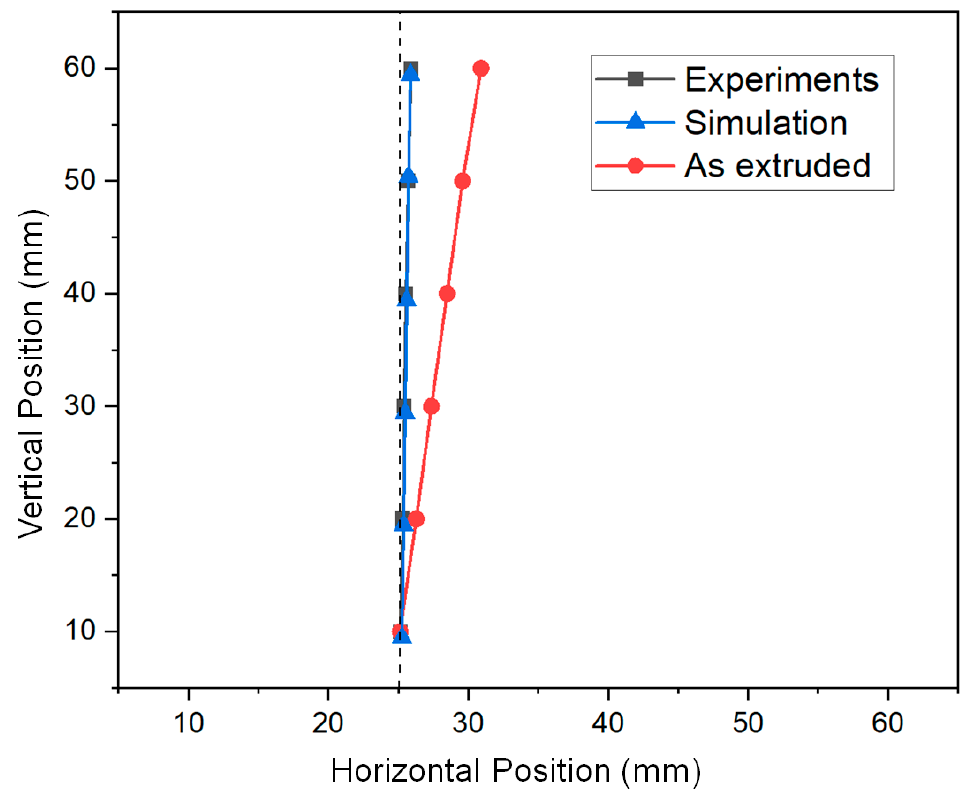
Figure 6. Comparison of the experimental and simulated results of the profile sidewall in Case P1.